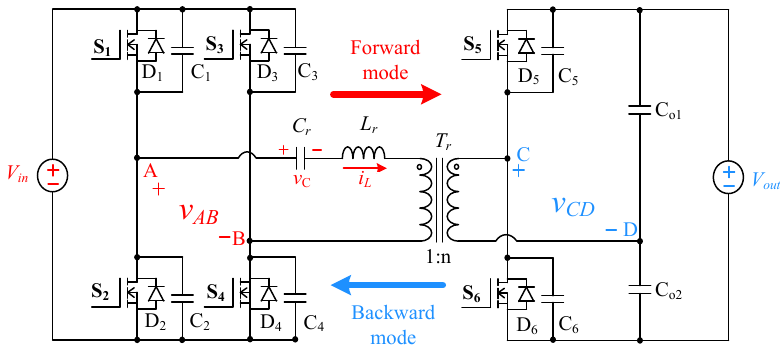
Figure 1. Topology of the proposed Half-Dual Bridge Resonant